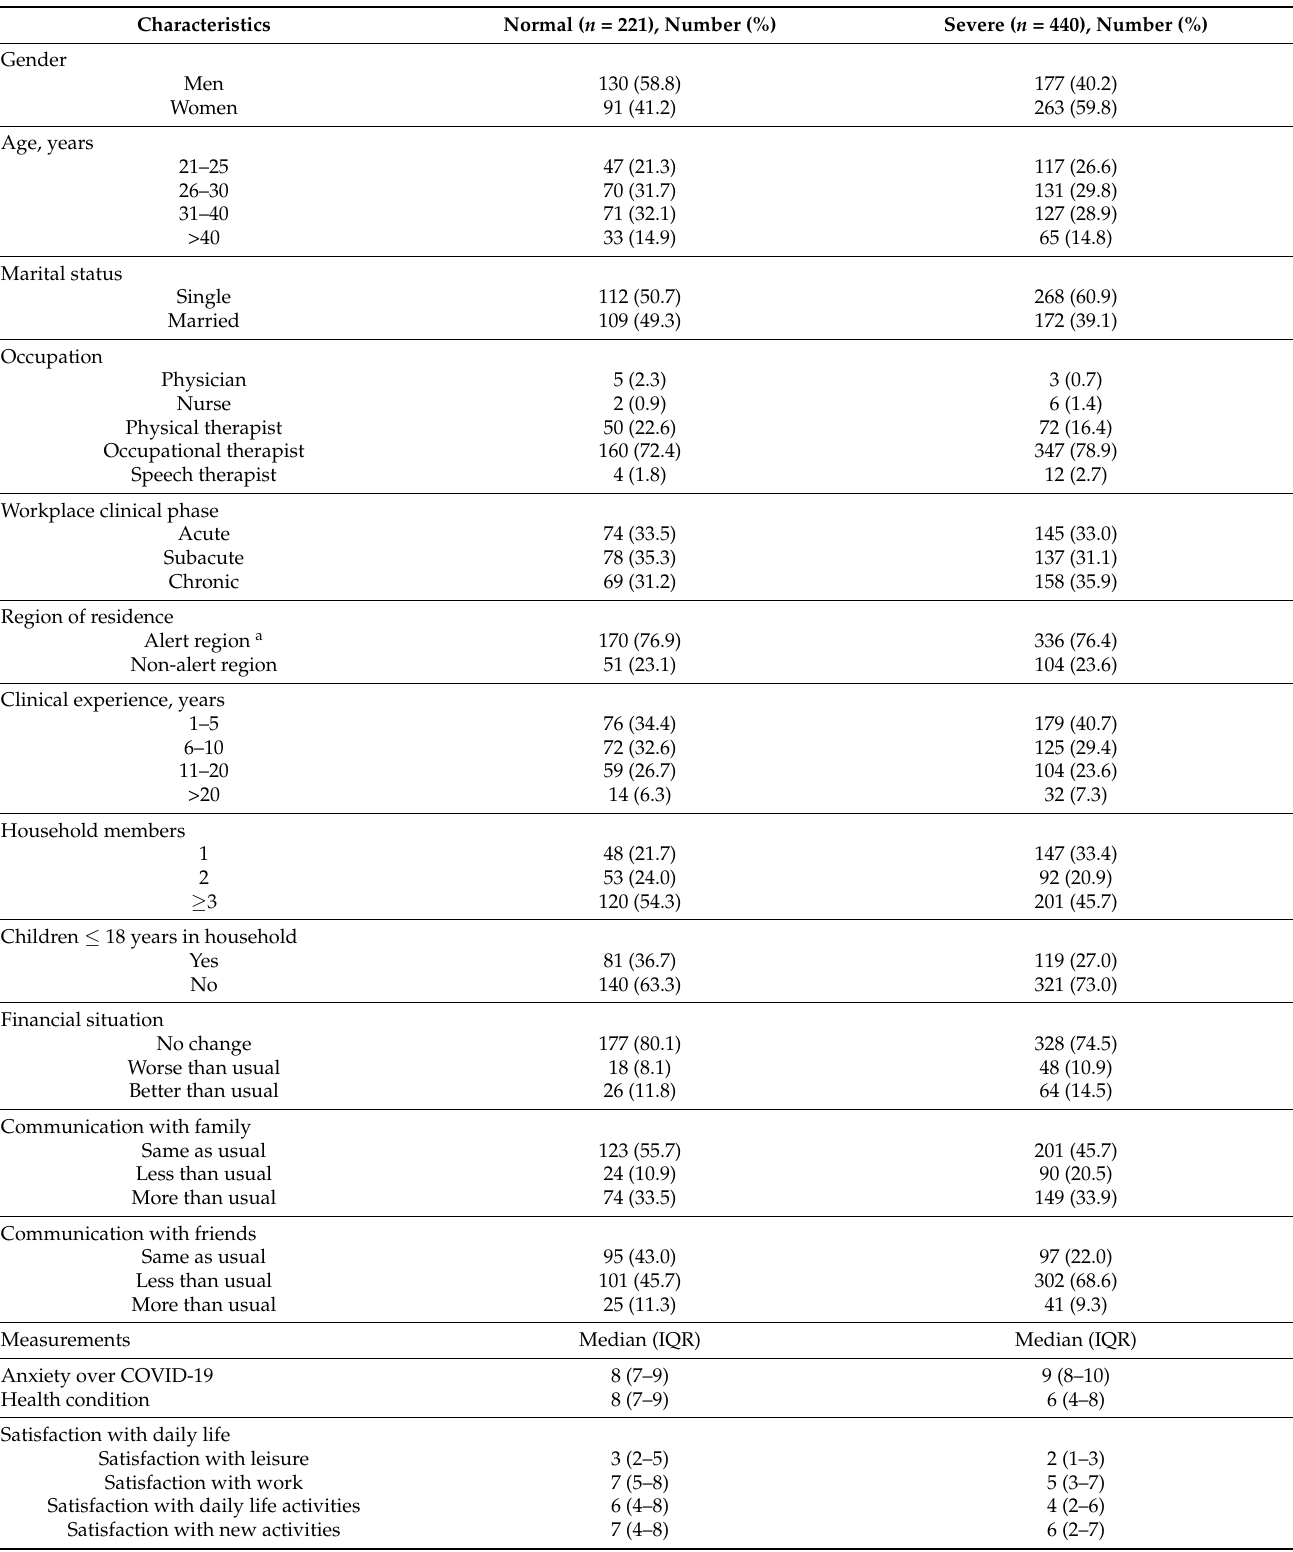
Table 3. Characteristics and mental health measurements of the normal mental health and severe mental health problems